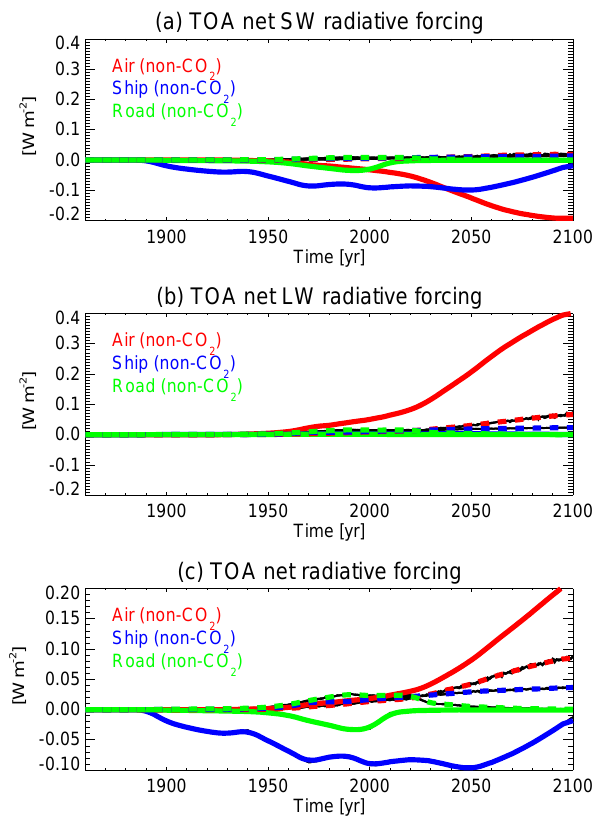
Fig. 7. Time series of annual global mean impact of O 3 , aerosols and contrails on TOA (a) shortwave, (b) longwave and (c) net radia- tive fluxes from road transport (green), maritime shipping (blue) and aviation (red). The impact from O 3 (from the fixed O 3 approach) is indicated by the dashed lines, while the impact from aerosols and contrails together is indicated by the full lines.